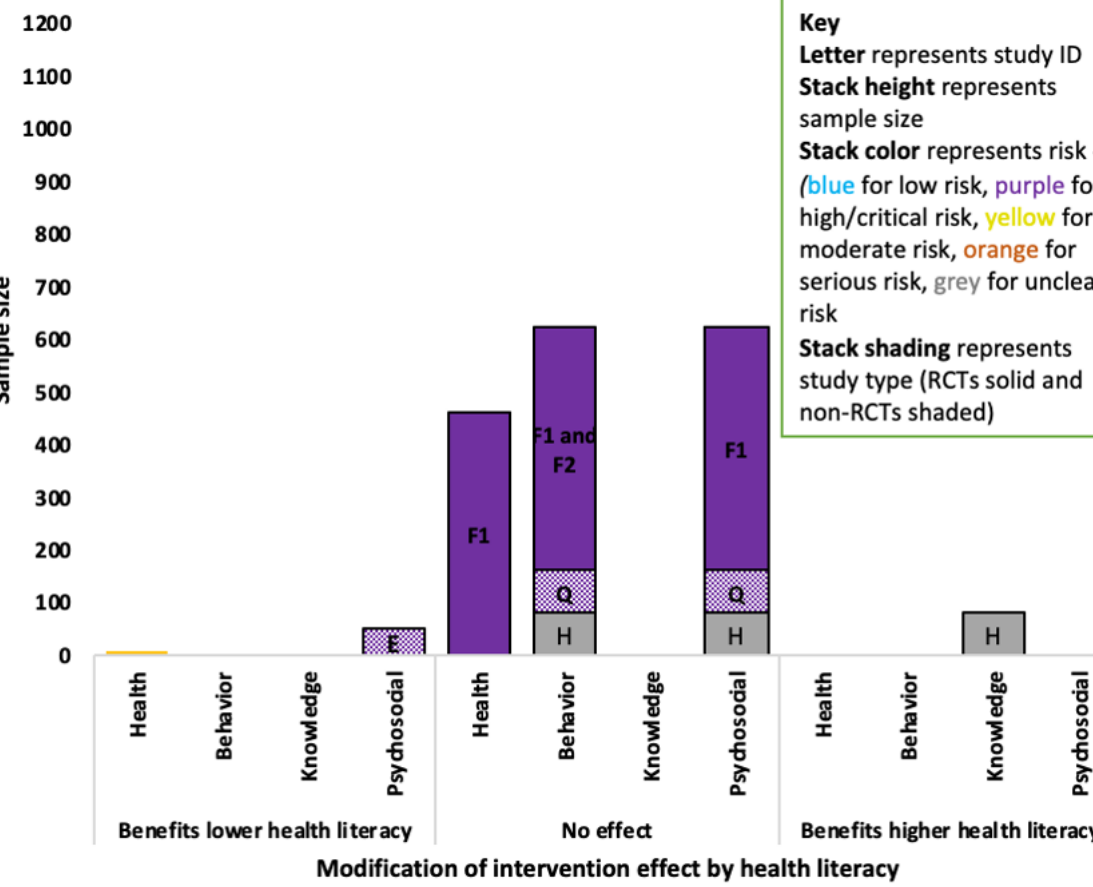
Figure 9. Adapted Harvest plot for higher health literacy modifying intervention effects across outcomes in diabetes studies. RCT: randomized controlled